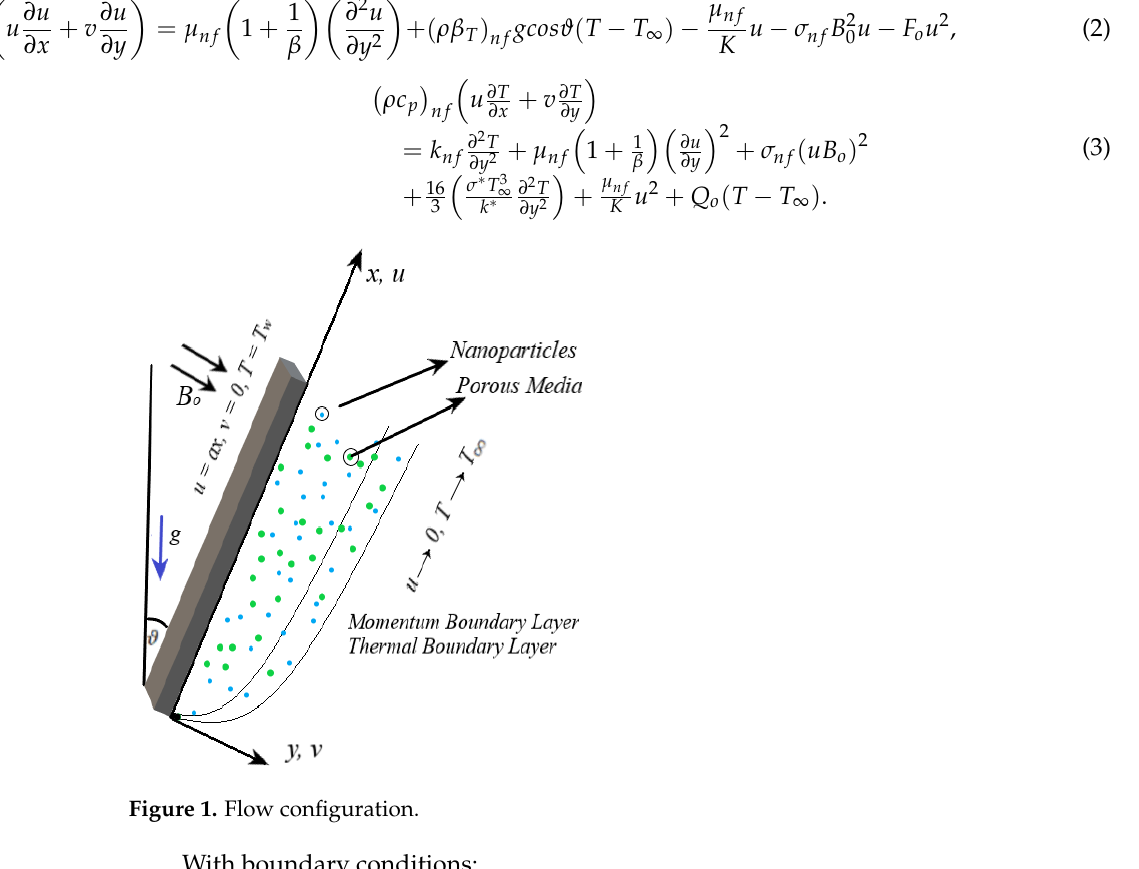
Figure 1. Flow Figure 1. Flow configuration.